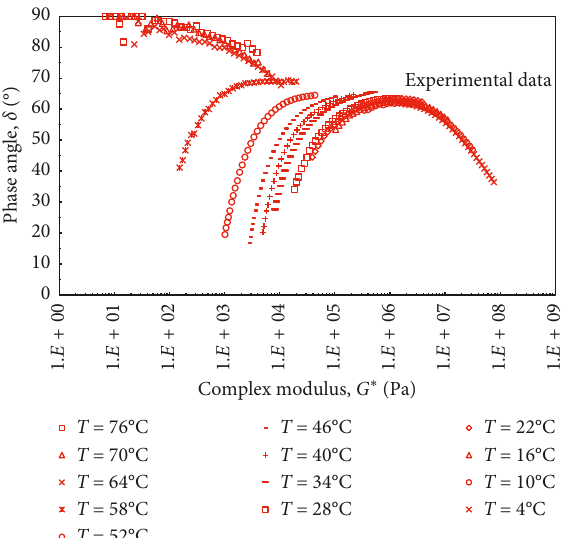
Figure 15: Black diagram ( δ vs. G